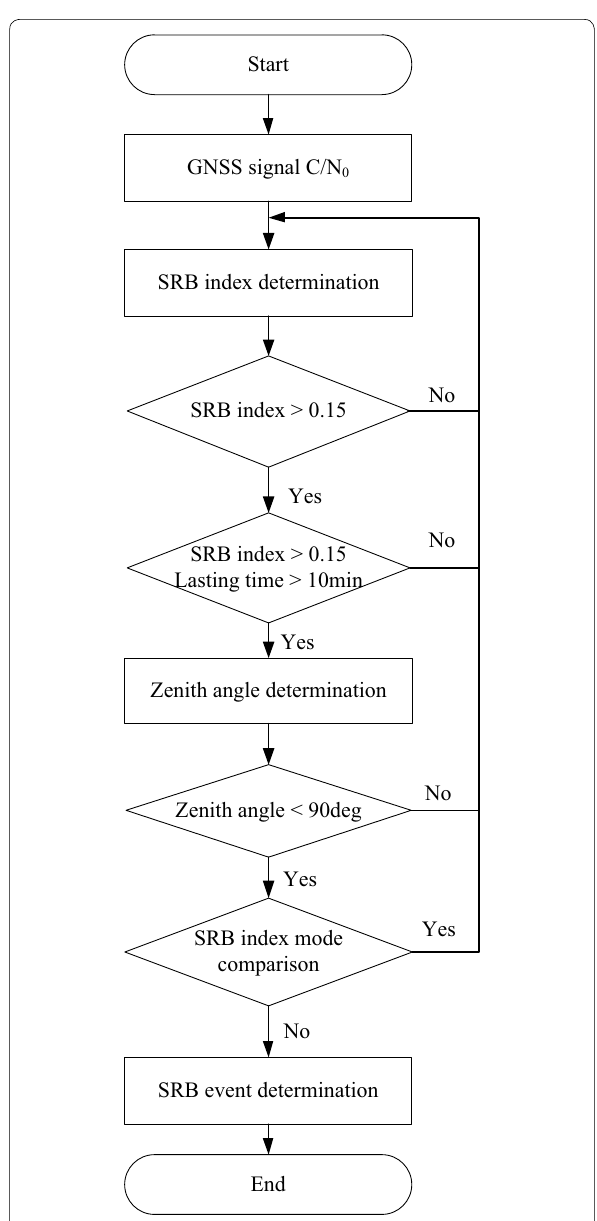
Fig. 13 Method of discovering a possible SRB